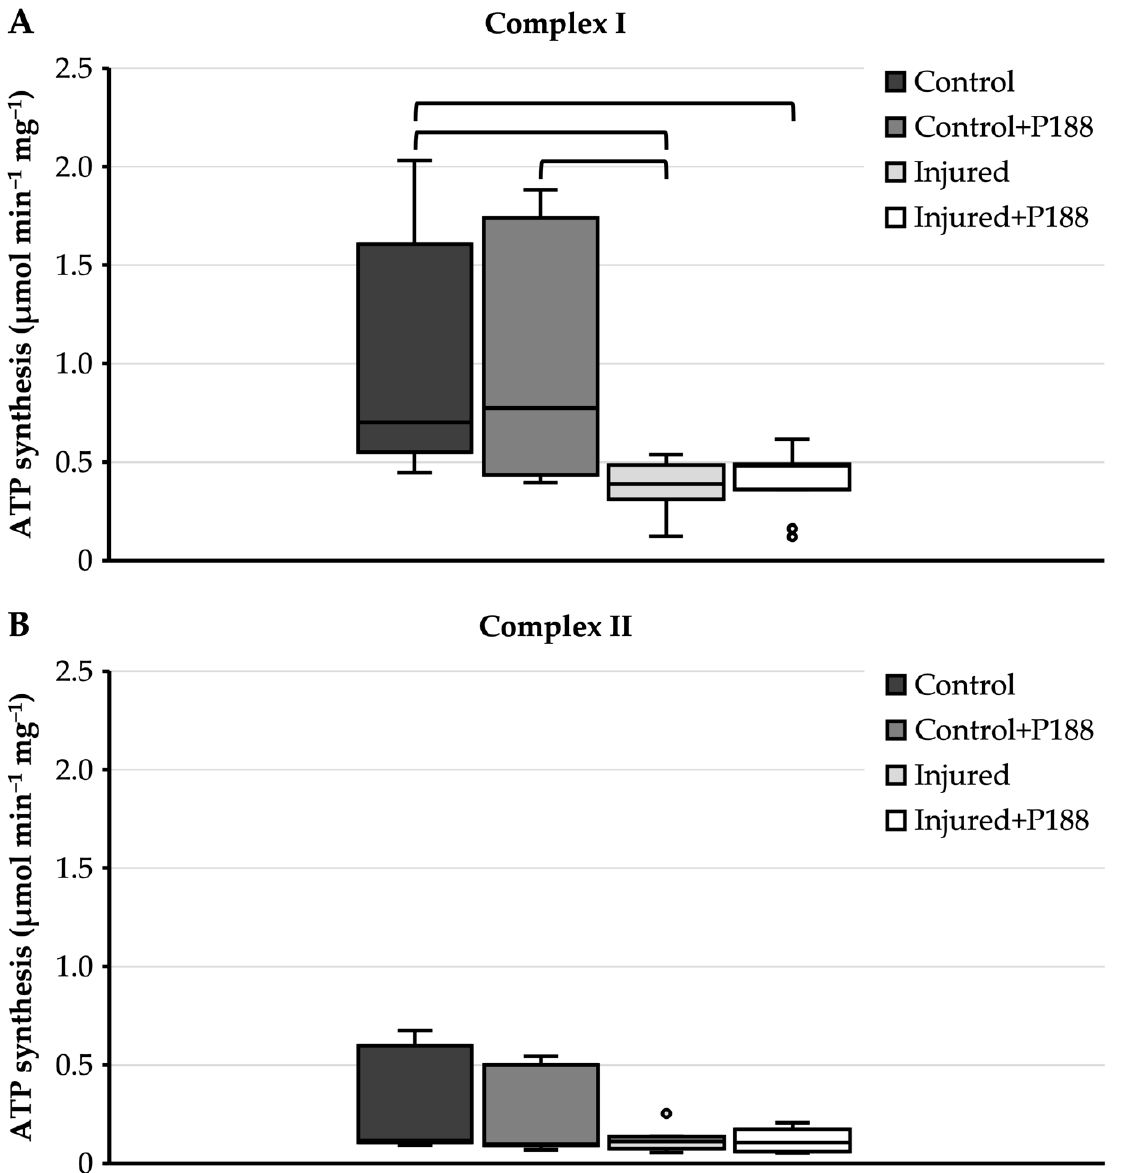
Figure 1. Adenosine triphosphate (ATP) synthesis (µmol ⋅ min − 1 mg − 1 ) in hydrogen peroxide (H 2 O 2 )-injured, isolated mitochondria for complex I ( A ) and II ( B ) substrates in control, control + Poloxamer (P)188, injured, and injured + P188 mitochondria. Boxplots show 25th, 50th, and 75th percentile; whiskers represent minimum and maximum. Statistical significance ( p < 0.05) denoted by brackets; complex I: n = 5, complex II: n = 5.